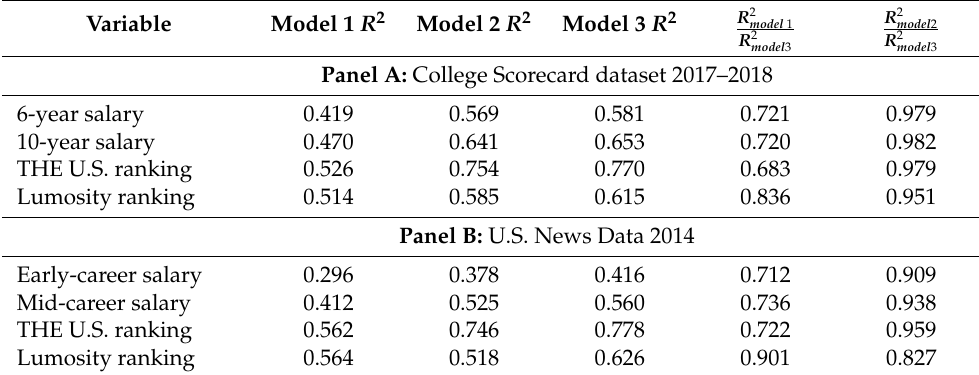
Table 4. Proportion of explained variance using Model 1, Model 2, and Model